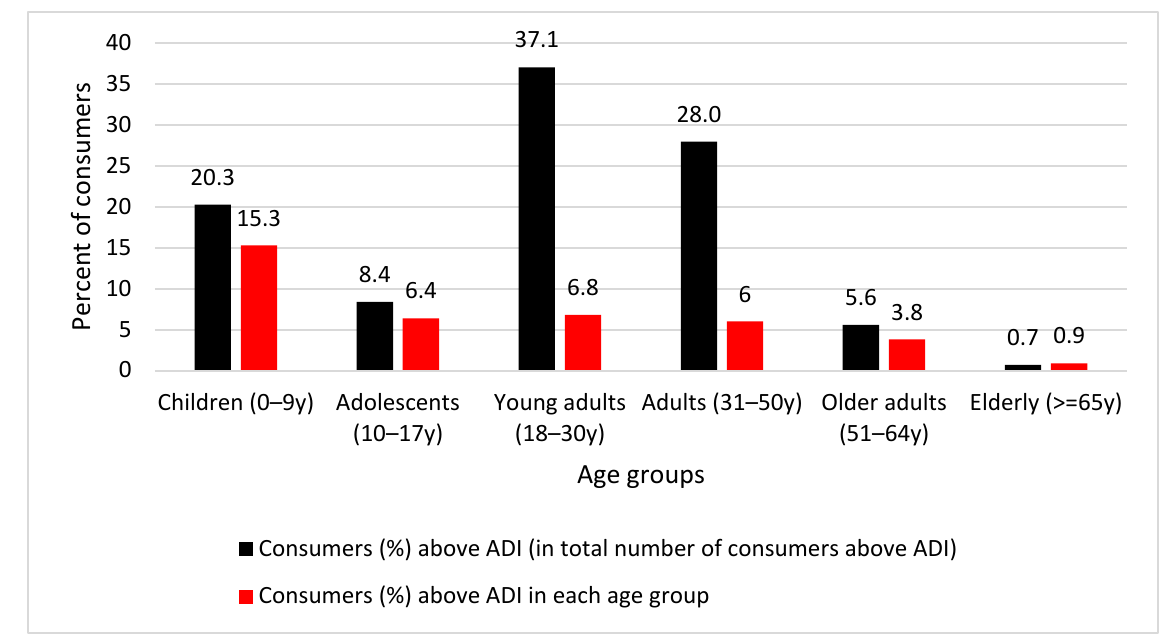
Figure 2. Proportion of the population per age group that exceeds the ADI of 0.07 mg/kg bw/day for nitrite in total exceeders and within the same age group.